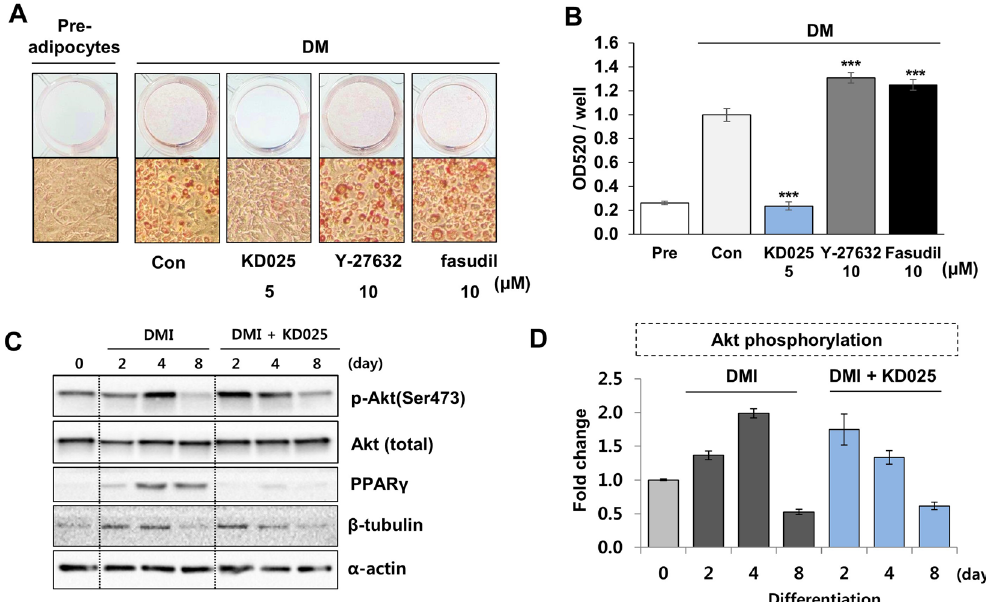
Figure 5. Effects of ROCK inhibitors on insulin action and signaling. ( A ) 3T3-L1 cells were differentiated through incubation in DM (without insulin) with KD025, Y-27632, or fasudil, as previously indicated, and stained with Oil Red O on day 8. ( B ) Lipid accumulation was assessed by measuring the absorbance at 520 nm of Oil Red O. *** p < 0.001 vs . DM control. ( C , D ) 3T3-L1 cells were differentiated in DMI-containing media with or without KD025 for 2, 4, or 8 days. ( C ) Cells lysates were subjected to SDS-PAGE and immunoblotted with anti-phospho-Akt (Ser473) and total Akt antibodies. PPAR γ was used as a differentiation marker, and β -tubulin and α -actin as loading controls. ( D ) The level of phosphorylated Akt at Ser473 residue was illustrated during adipogenesis. * p < 0.05; ** p < 0.01; *** p < 0.001 vs . insulin + vehicle untreated. The data are the representative from more than three independent experiments. Data are expressed as means ± S.E. based on